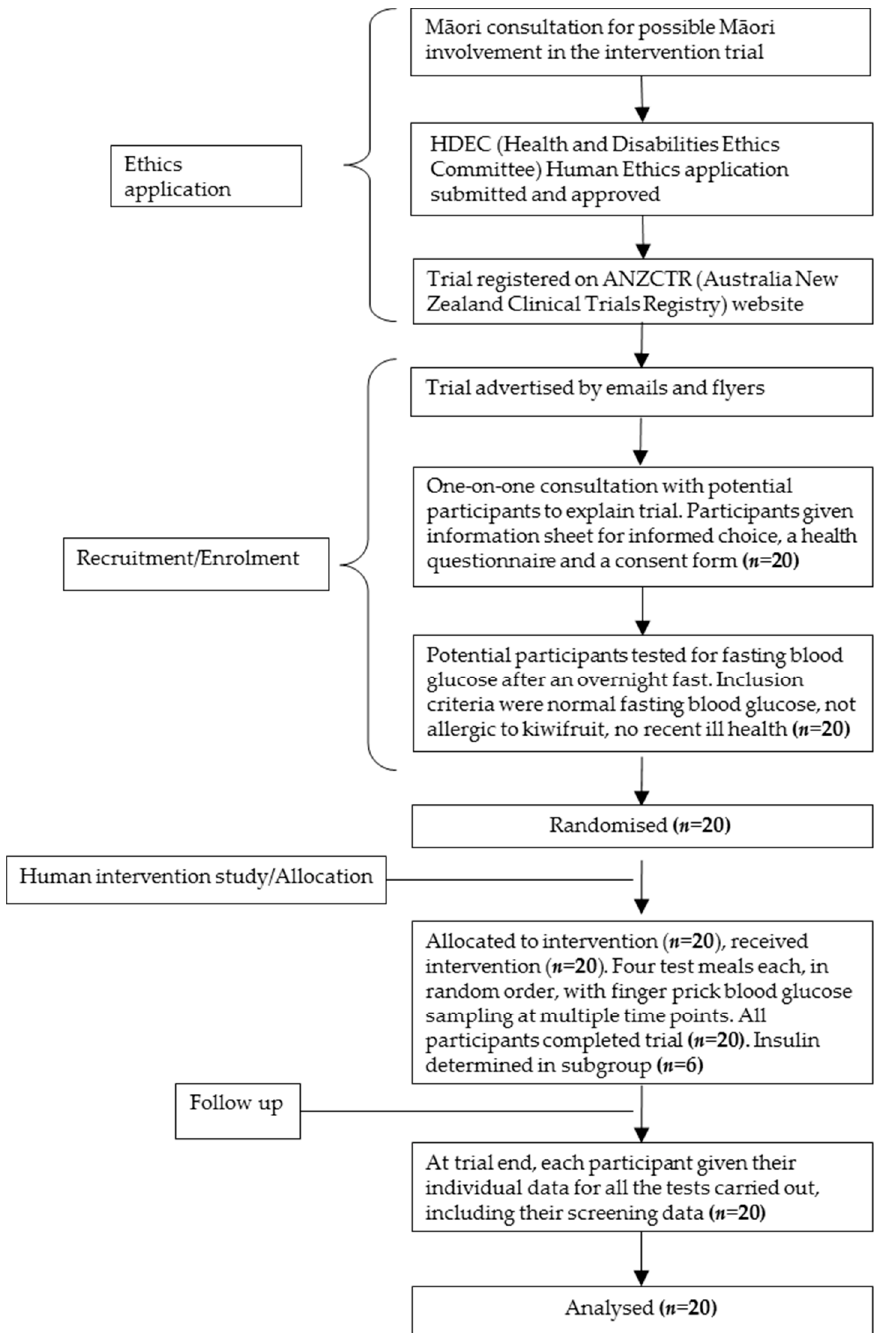
Figure 1. Participant flow chart for clinical determination of the relative glycaemic potency of kiwifruit.